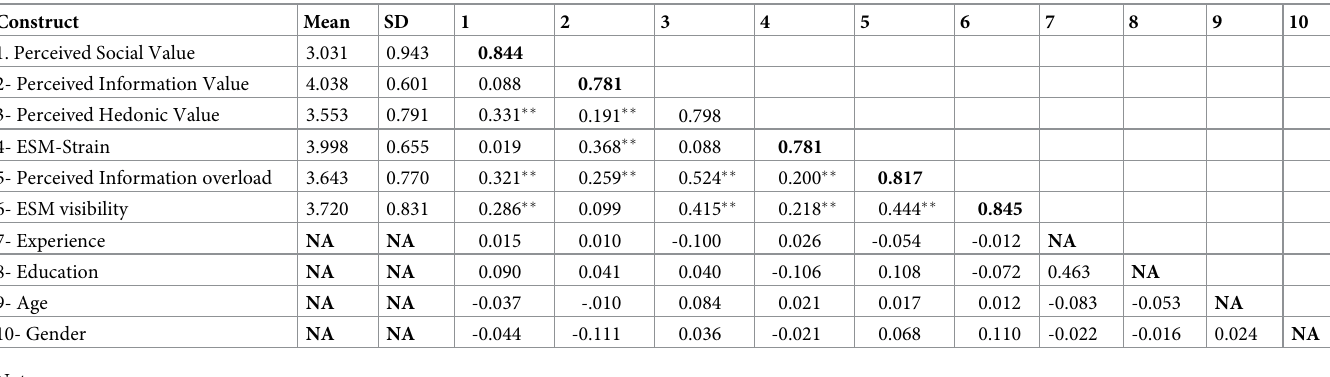
Table 3. Correlation matrix and mean, standard